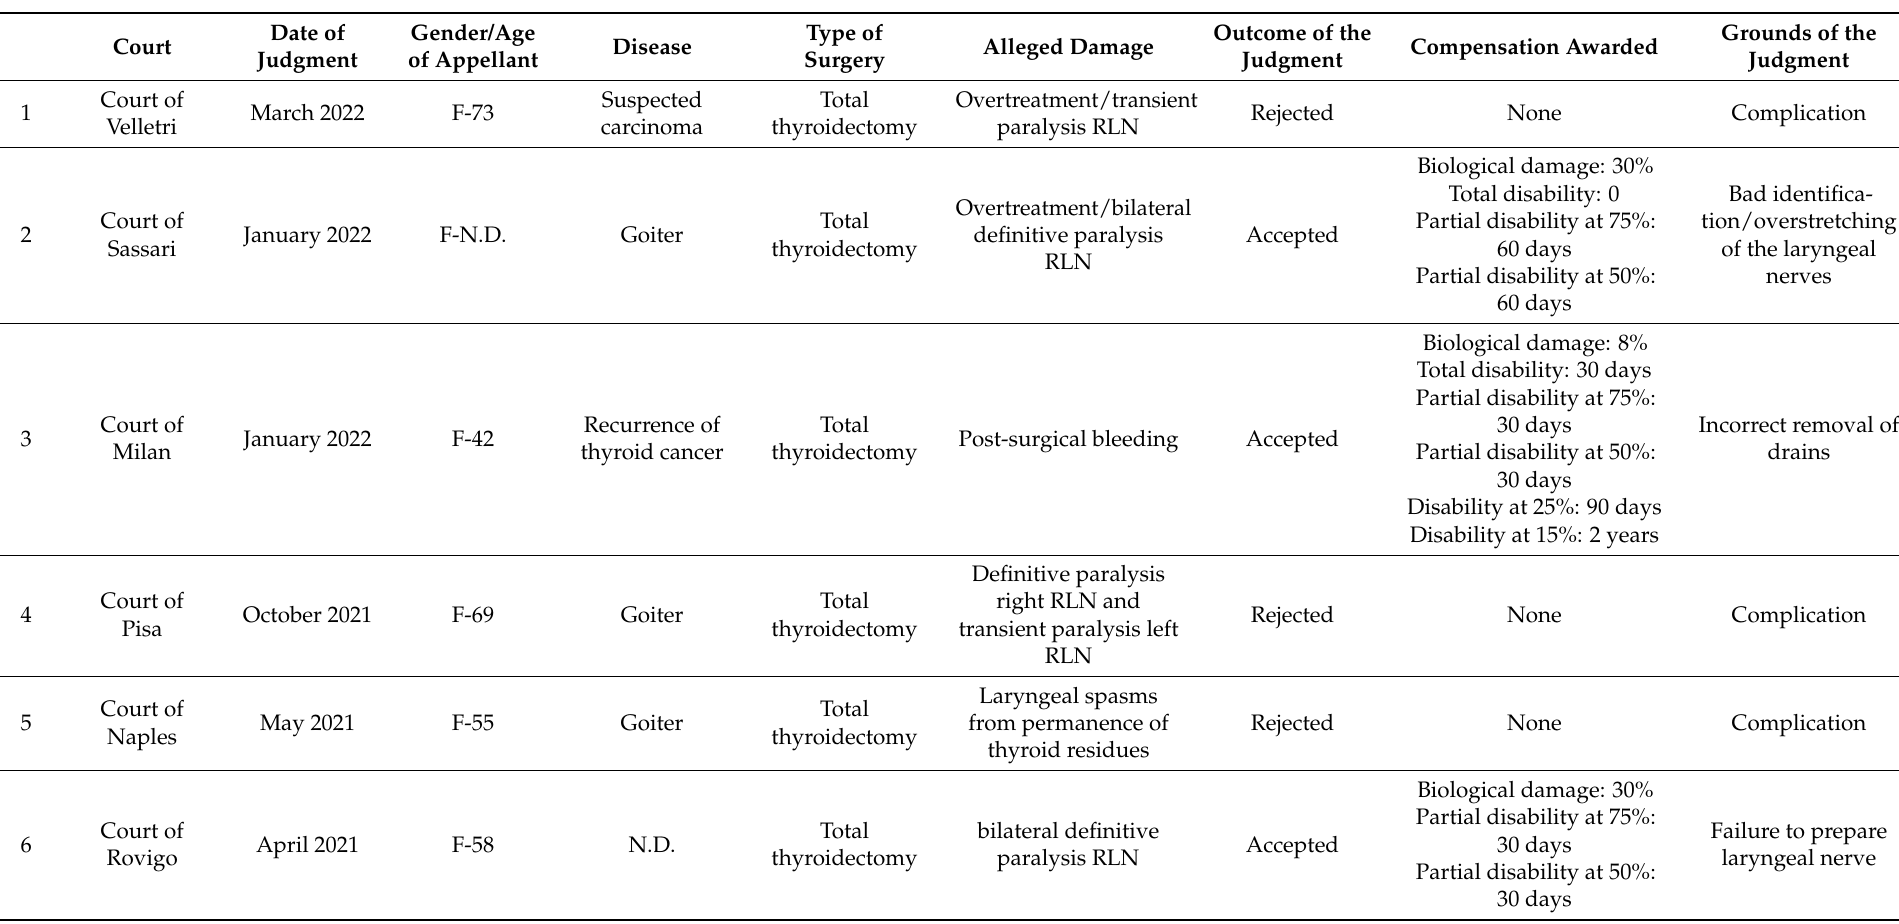
Table 1. (characteristics analyzed) (N.D.: not